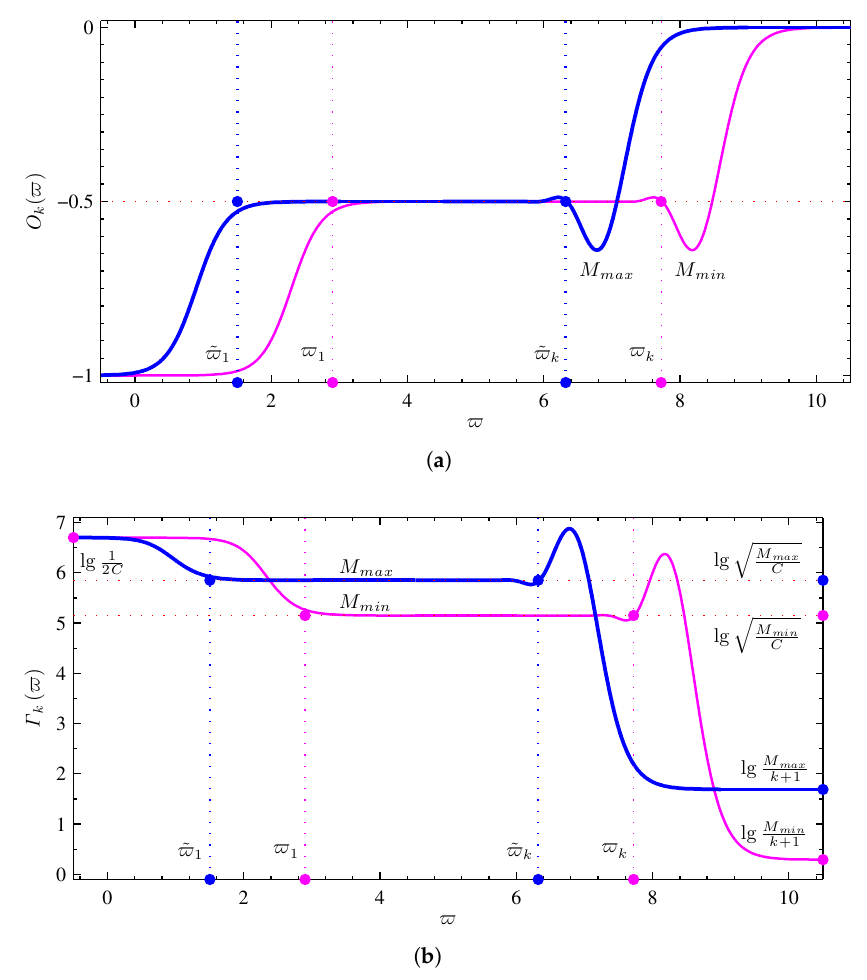
Figure 2. Frequency domain characteristic curve of the half-order chain-type fracmemristor circuit: ( a ) order-frequency characteristic curve; ( b ) F-frequency characteristic